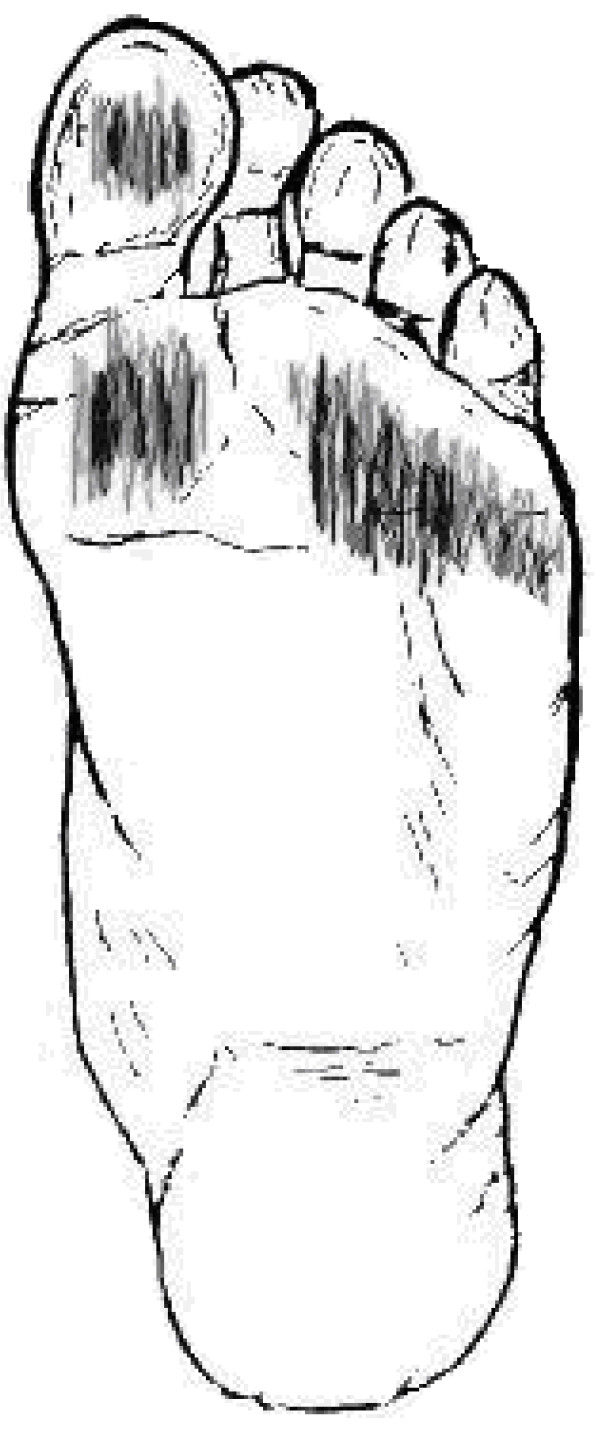
Marking of regions with elevated plantar pressure. Presumed regions with elevated plantar pressure are marked through hatching an illustration of a plantar aspect.